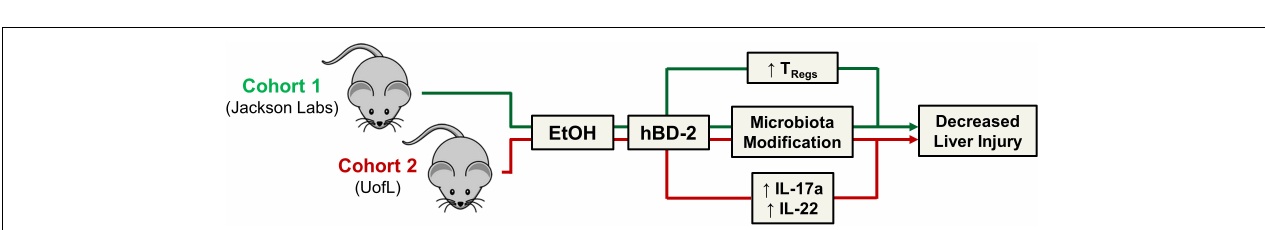
FIGURE 7 | Genus-level effects of hBD-2. Relative abundance (%) is shown for seven genera of interest in EtOH-associated liver disease, specifically, Barnesiella , Parabacteroides , Akkermansia , Alistipes , Roseburia , Oscillobacter , and Lactobacillus ( A–G , respectively). Data are reported as mean ± standard error of the mean. * p < 0.05.